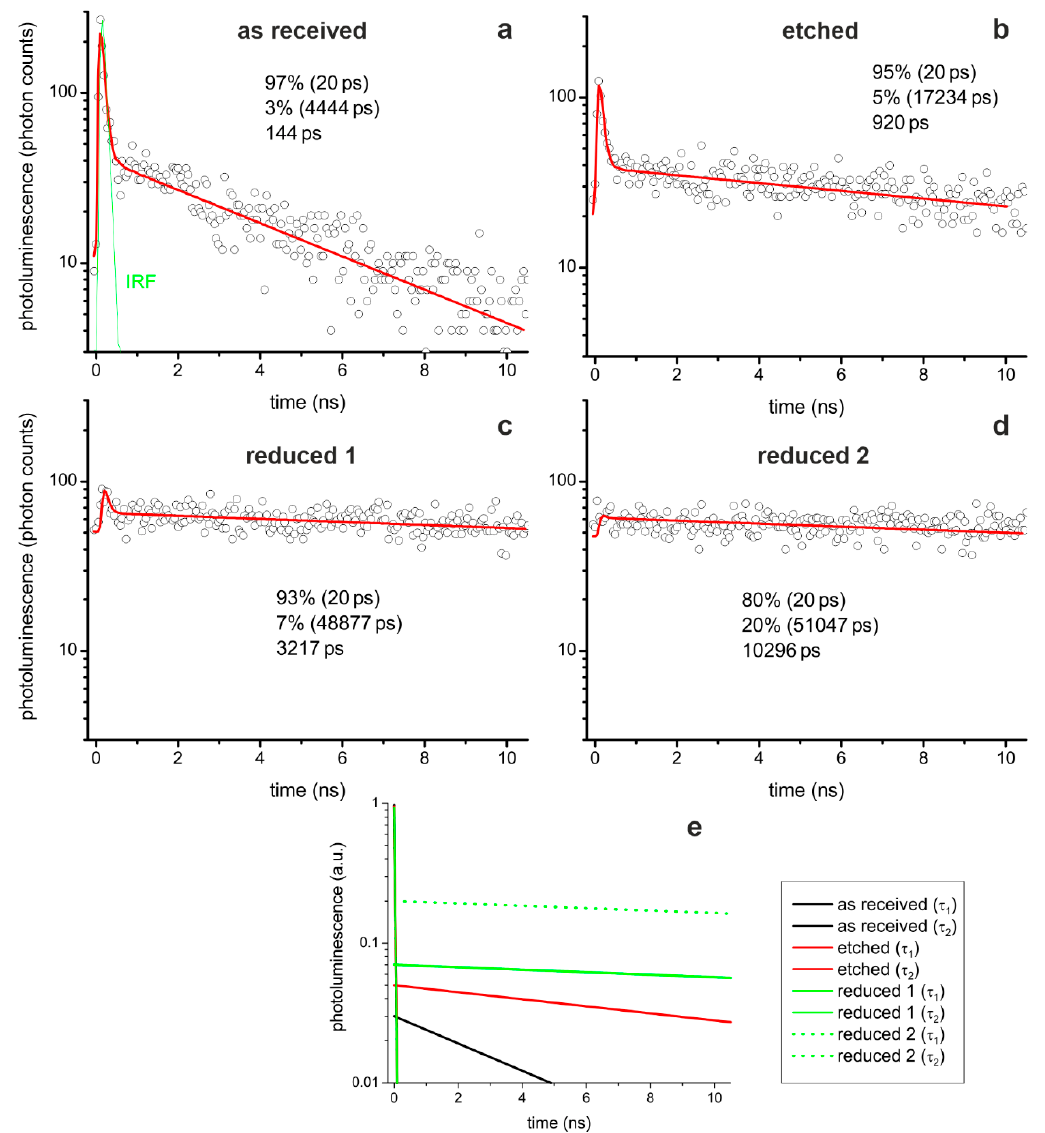
Figure 10. Exemplary photoluminescence decay traces ( ○ ) obtained at the SrTiO 3 surface away from the bicrystal boundary; as-received ( a ), HF etched ( b ), and reduced ( c,d ). For the reduced crystal, the decays at two different spots are shown, illustrating the variation in the signal. The green line in a) represents the instrument response function (IRF). The biexponential-fit functions convoluted with the IRF are drawn in red. The fit parameters – a 1 ( τ 1 ), a 2 ( τ 2 ) – and amplitude-weighted average photoluminescence time, respectively, are given in insets. ( e ) Visualization of the two fitted exponential functions.